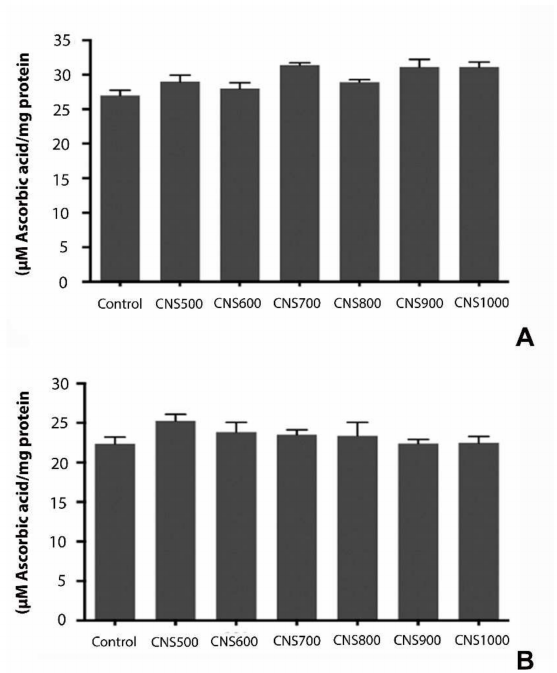
Figure 8. Estimation of total antioxidant capacity (TAC) in response to dietary exposure to CNS500, CNS600, CNS700, CNS800, CNS900, and CNS1000 CNSs for 25 days at 1000 µ g/mL dose in ( A ) male and ( B ) female flies. TAC was estimated using the phosphomolybdenum method and values are represented as mean ± SEM; statistical significance was set at p < 0.05 when compared to control (n = 3 and 25 flies per treatment group).